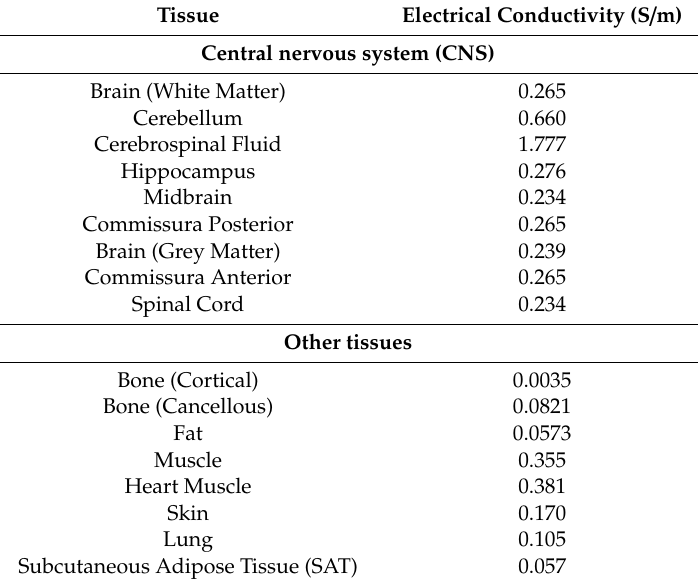
Table 1. Electrical properties of some